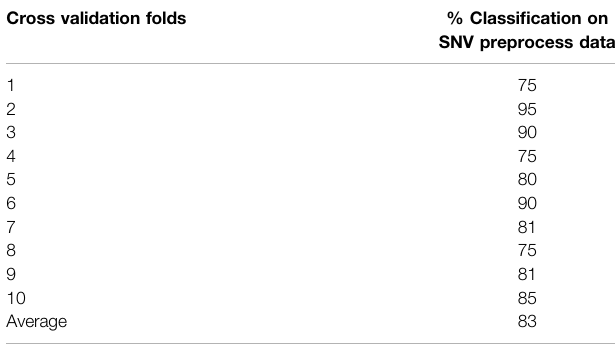
TABLE 2 | Result of 10-fold cross-validation. Cross validation